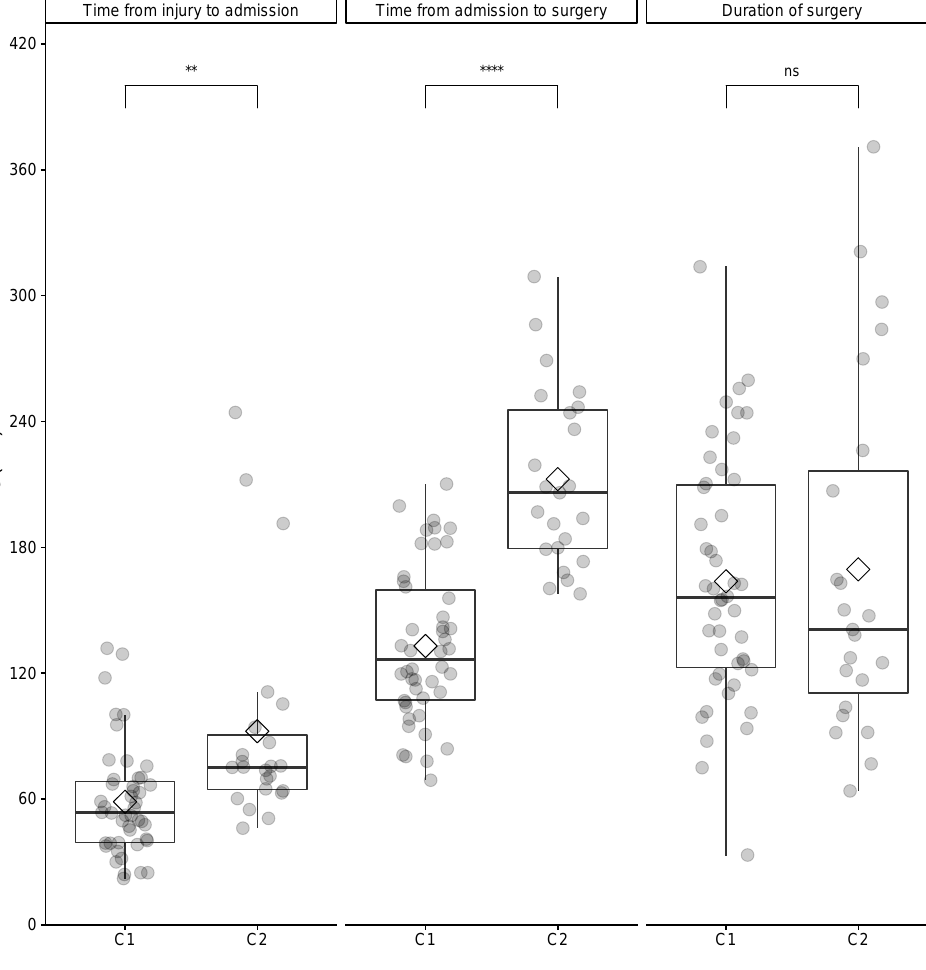
Figure 2. Overview of timing intervals of C1 vs. C2. Note. C1, Cohort 1: time from injury to injury <4 h; C2, Cohort 2: time from injury to injury = 4–24 h; Circles: raw data; Rhombus: mean; ns, not significant, p > 0.05; **, p < 0.01; ****, p <